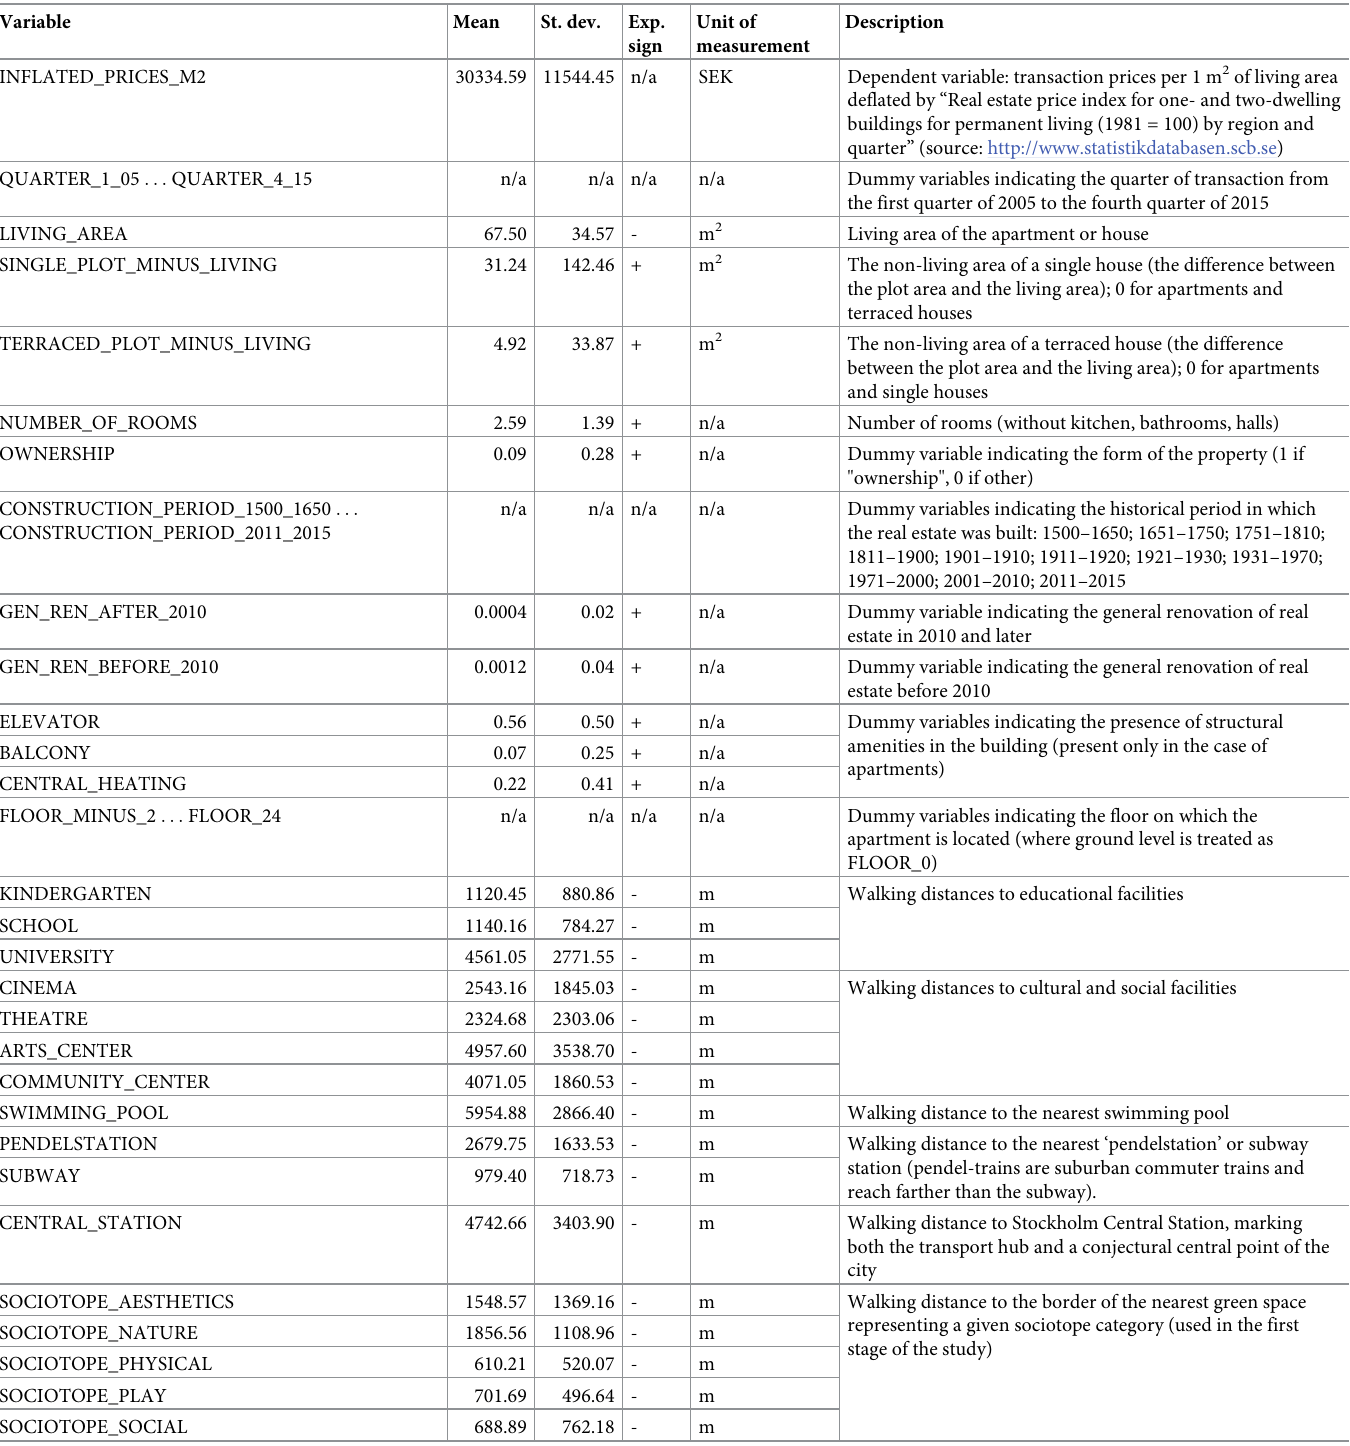
Table 2. List of